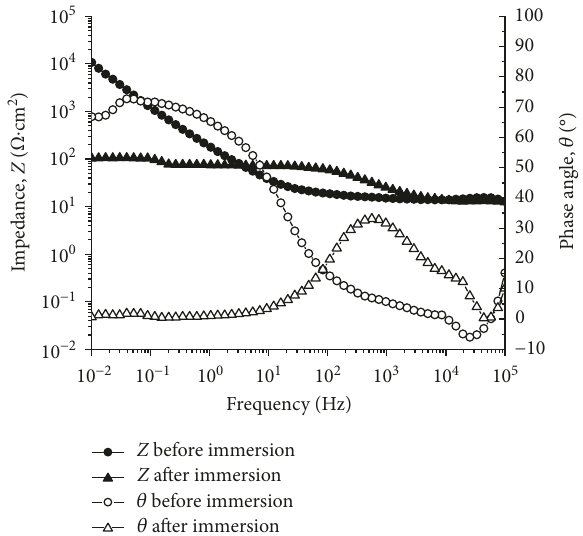
Figure 4: Impedance and phase angle spectrums before and after immersion in boric acid (sample